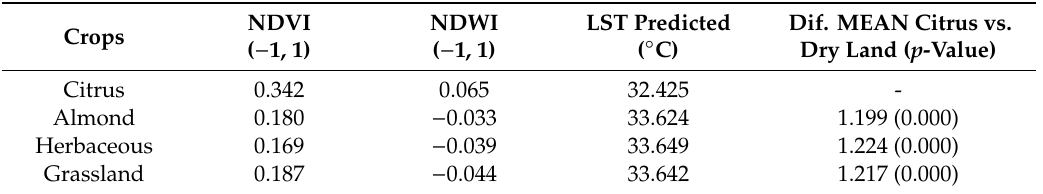
Table 5. Predictions of LST for irrigated and rain-fed